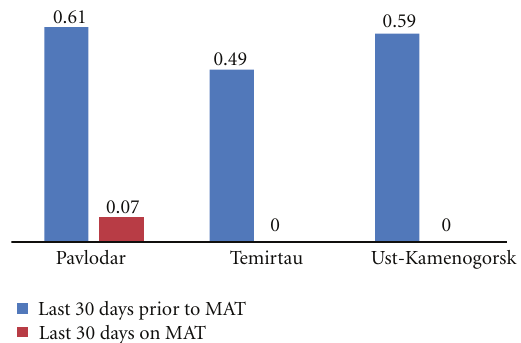
Figure 3: Use of heroin according to mean Opiate Treatment Index scores in patients before and after enrollment into medication- assisted treatment, by site.